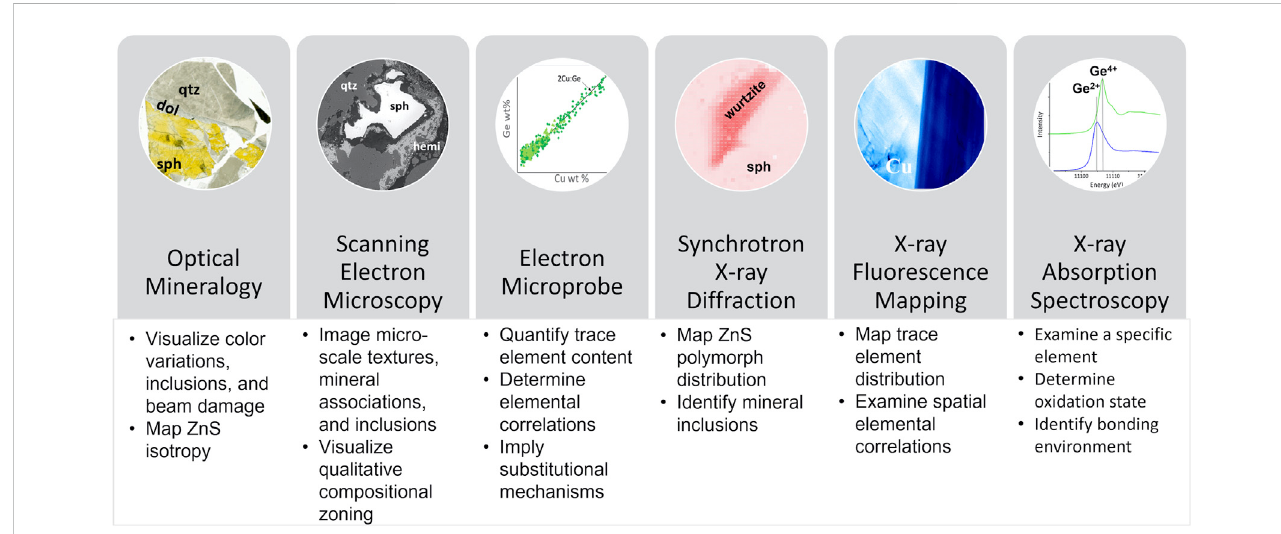
FIGURE 1 A complementary suite of micro-focused techniques used in this study to examine Ge and co-substituents in ZnS. These techniques were typically employed progressing from left to right, but iterative use proved essential for comprehensive